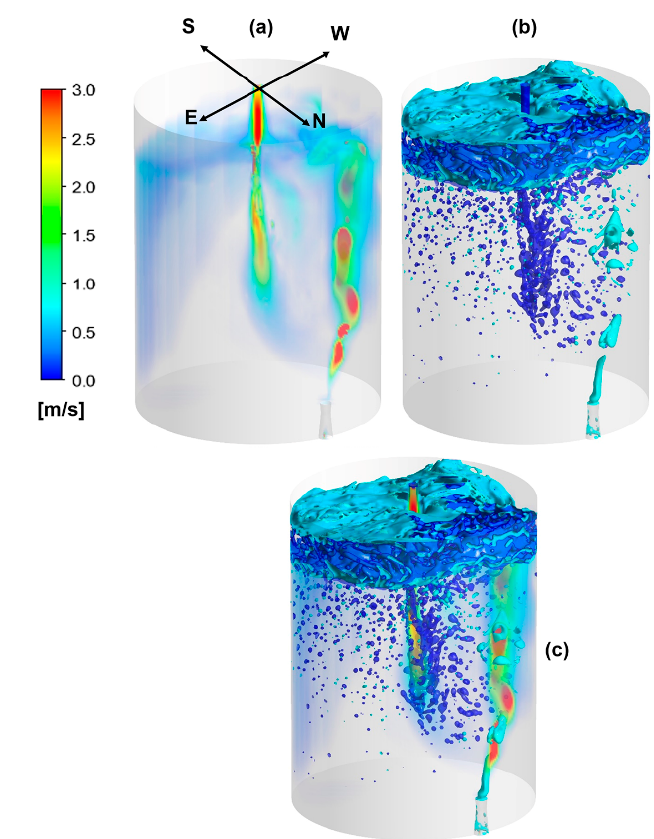
Figure 16. ( a ) 3D view of the velocity field ( b ) Dynamics of Interfaces air-argon, ( c ) 3D view of the velocity with interface air-argon. Bath level of 80 tons.